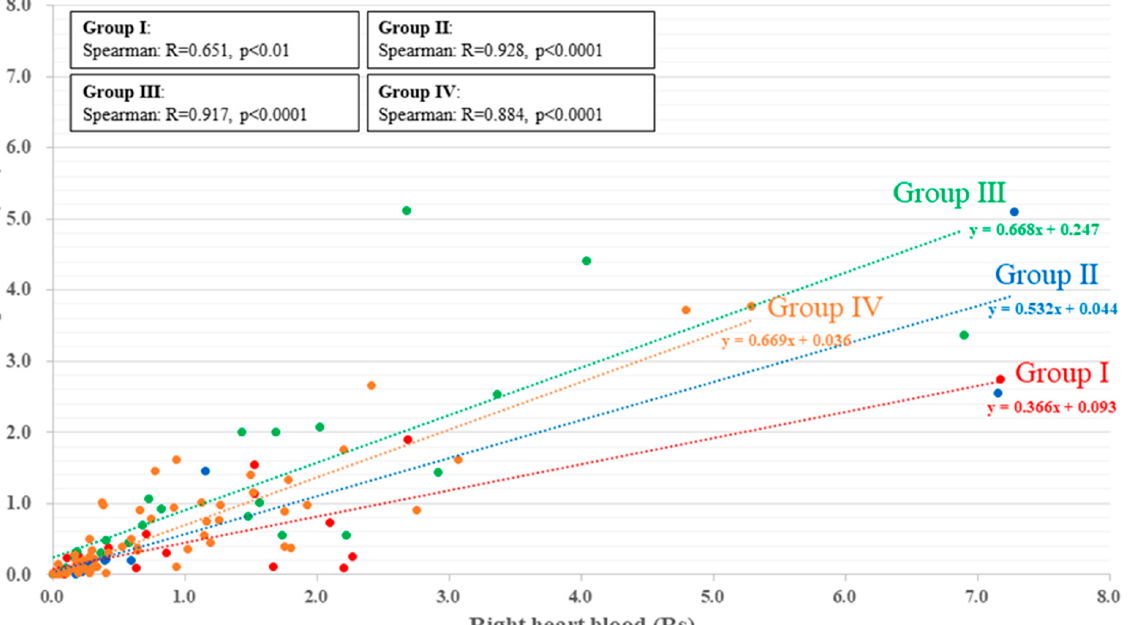
Figure 1. The correlation between the concentration of caffeine in Rs and that in CSF in Groups A (red) and B (blue). There is a correlation between the caffeine concentrations in Rs and in CSF in both groups (Group A: r = 0.795, p < 0.0001 Group B: r = 0.903, p < 0.0001). The concentration of caffeine is higher in Rs than in CSF in Group A.